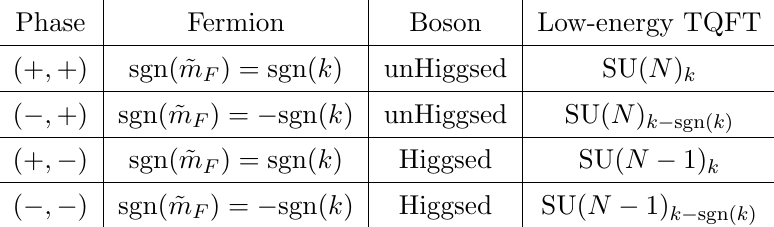
Table 1. The four massive phases of the one boson-one fermion theory. The notation is ( F; B ) with F and B being the fermionic and bosonic phases respectively. The e(cid:11)ective fermion mass is denoted by ~ m F and sgn( ~ m F ) and sgn( k ) are the signs of ~ m F and k respectively. We list